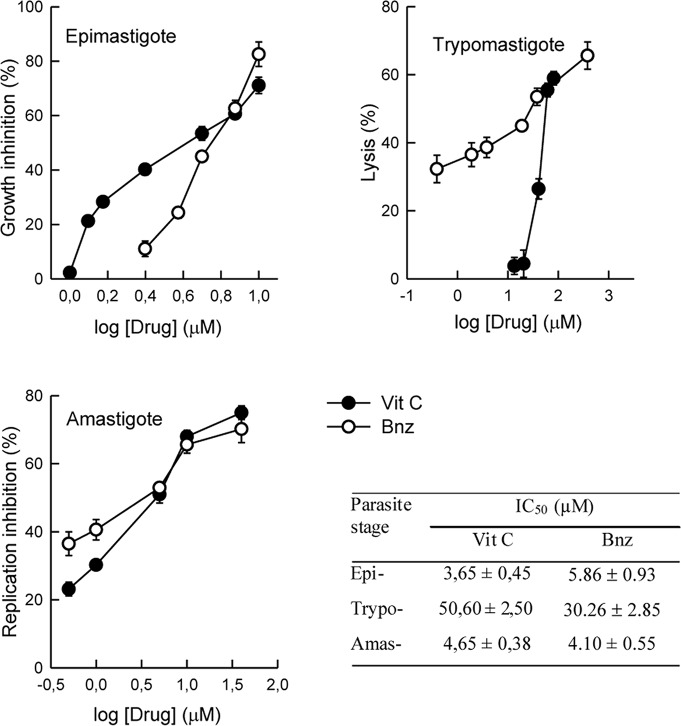
Antiparasitic activity of Vit C and Bnz on T. cruzi epimastigote, trypomastigote and amastigote forms.Vit C concentrations assayed ranged from 1 to 10 μM for epimastigotes, 5 to 100 μM for trypomastigotes and 0.5 to 40 μM for amastigotes. For Bnz, used as reference drug, the concentrations tested ranged from 2.5 to 10 μM for epimastigotes, 0.38 to 380 μM for trypomastigotes and 0.5 to 40 μM for amastigotes. IC50 values were calculated (see Materials and Methods) and shown in the inset table.